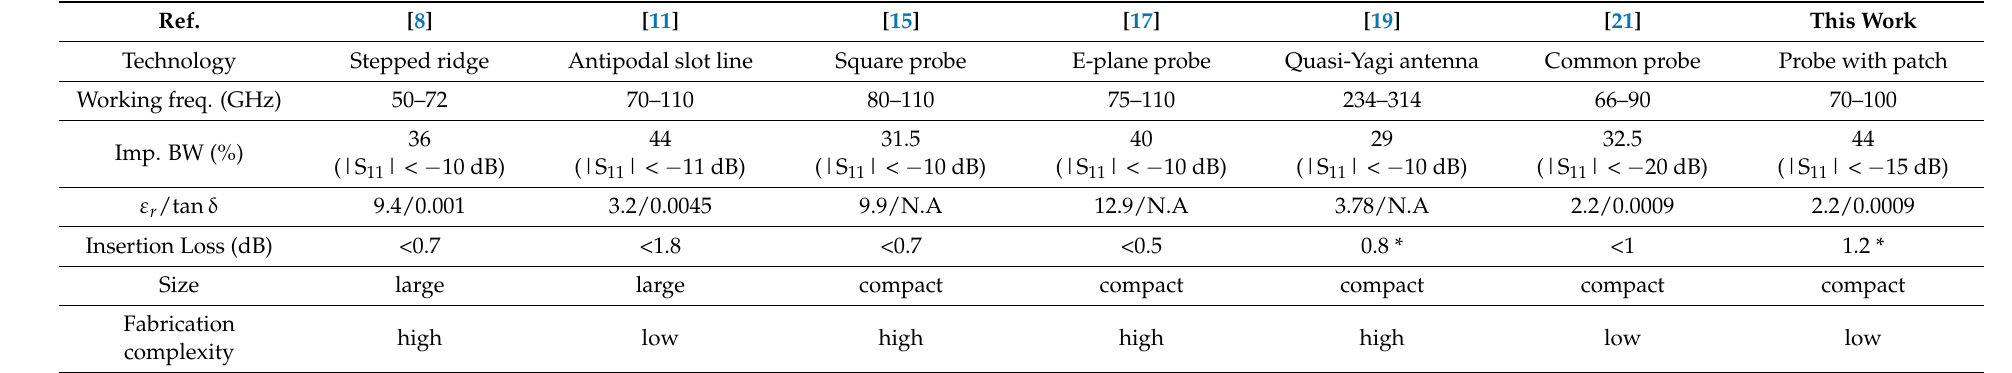
Table 2. Comparison among the transitions from the transmission line to rectangular